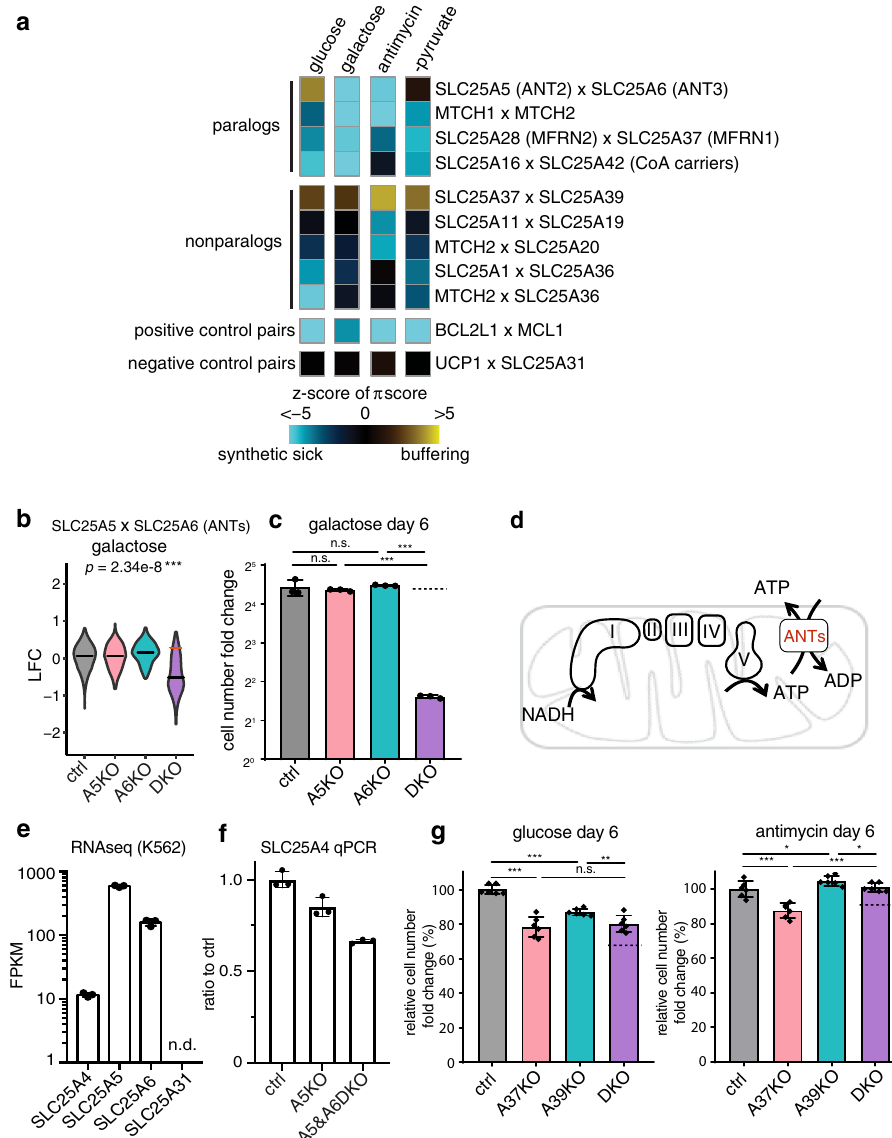
Fig. 3 Identi fi cation of Gene x Gene x Environment (GxGxE) interactions. a Heatmap shows the π -score for pairwise genetic interaction. The values are z-transformed to compare across media conditions, as described in the methods. For comparison, a positive control pair (BCL2L1 x MCL1) that are always detrimental when jointly knocked out and another pair (UCP1 x SLC25A31) that do not interact are shown. The rows and columns are not clustered. b LFC values from the CRISPR screen are shown to illustrate the strongest synthetic sick genetic interaction observed from the CRISPR screen, SLC25A5 and SLC25A6 loss in the galactose condition. The red line indicates the expected LFC, based on an additive model, if there were no genetic interaction. The black line indicates the actual median LFC value. c Follow-up validation of the genetic interaction between SLC25A5 and SLC25A6 in the galactose ( p ctrl/A5KO = 0.59, p ctrl/A6KO = 0.66, p A5KO/DKO = 2.11 × 10 − 7 , p A6KO/DKO = 1.93 × 10 − 8 ). The dotted line indicates the expected growth fi tness, based on an additive model, if there were no speci fi c genetic interaction ( n = 3). d The cartoon illustrates the function of ANTs in supporting bioenergetics. e Transcript levels of the four ANTs in K562 cells (data plotted from the published PBS vehicle treated K562 cells RNA-seq dataset GSE74999) ( n = 3). f qPCR of SLC25A4 mRNA level in SLC25A5 KO and SLC25A5 and SLC25A6 DKO cells ( n = 3). g Follow-up validation of the genetic interaction between SLC25A37 andSLC25A39intheglucose( p ctrl/A37KO = 1.04×10 -5 , p ctrl/A39KO = 3.08×10 -6 , p A37KO/DKO = 0.56, p A39KO/DKO = 0.0092)andantimycin( p ctrl/A37KO = 0.00074, p = 0.0498, p = 5.54×10 -5 , p = 0.030)conditions( n = 6).Statisticalsigni fi cancewascalculatedusingtwo-tailed t test.Signi fi cance ctrl/A39KO A37KO/DKO A39KO/DKO level were indicated as*** p <0.001,** p < 0.01, * p < 0.05and n.s. p >0.05. Dataareexpressedasmean±SD.Source dataareprovidedasa Source Data fi